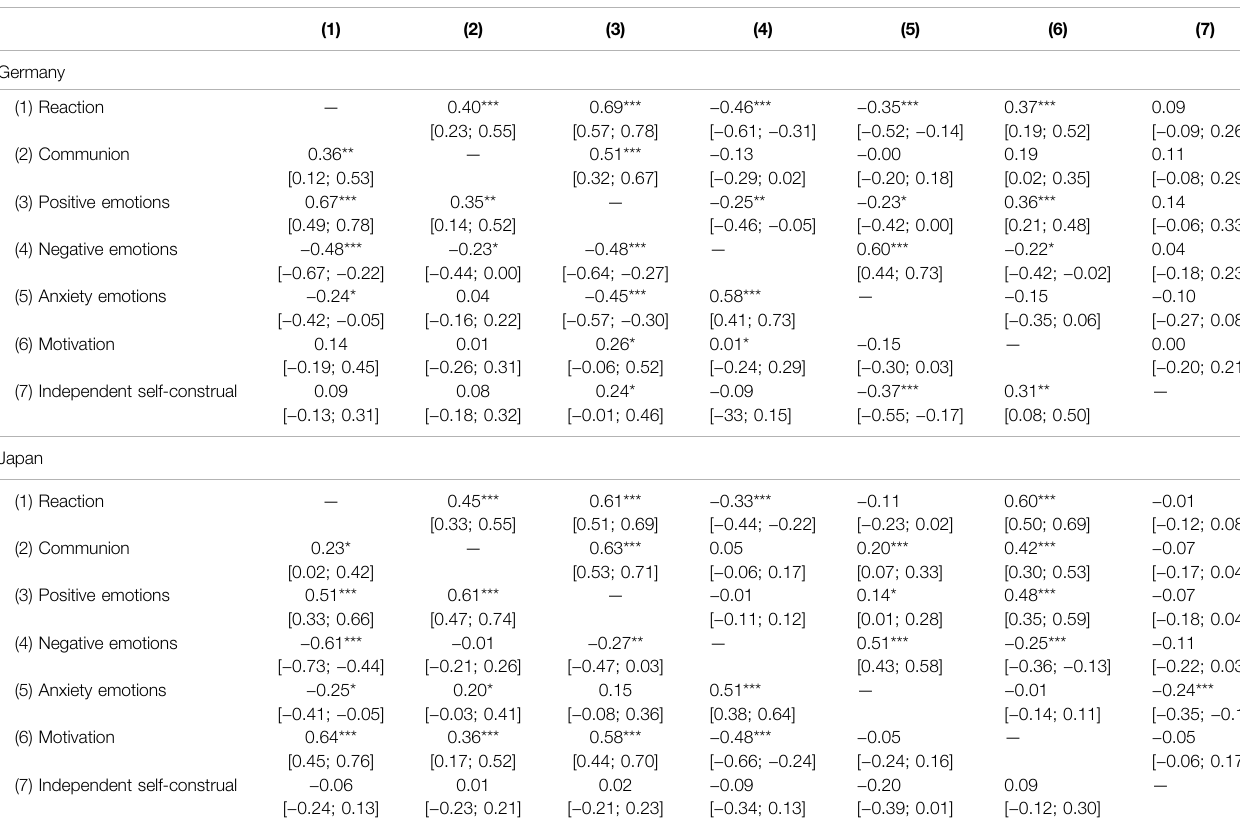
TABLE 2 | Bivariate correlations [r, (95%